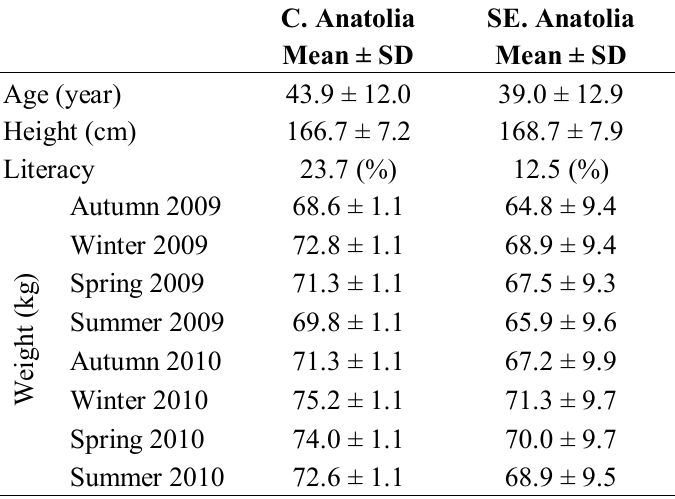
Table 2. Age, height, body weight of participants (means ±